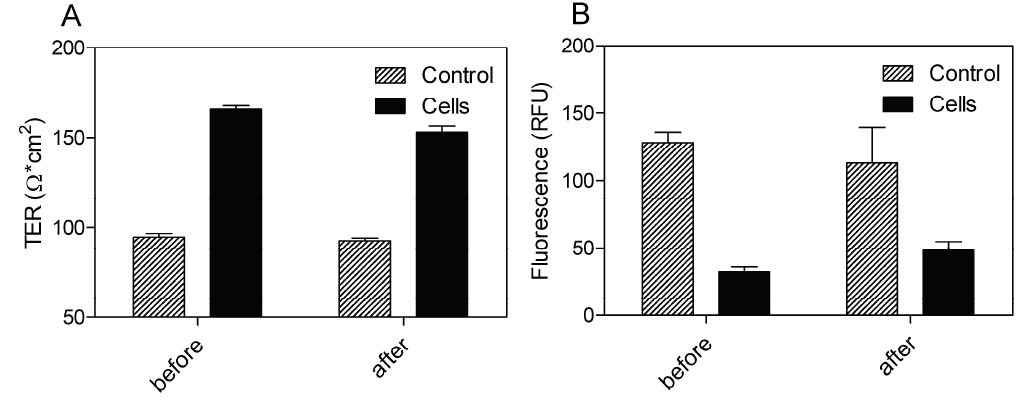
Figure 5. TER measurements ( A ) and FITC-dextran (4 kDa) permeation assay ( B ) of propranolol as system validation substance and SEV-SBE β CD complex. Collagen 4-coated empty inserts were used as a control. The fluorescence is measured in relative fluorescence units, abbreviated as RFU. Data represent means ± standard deviation of three independent